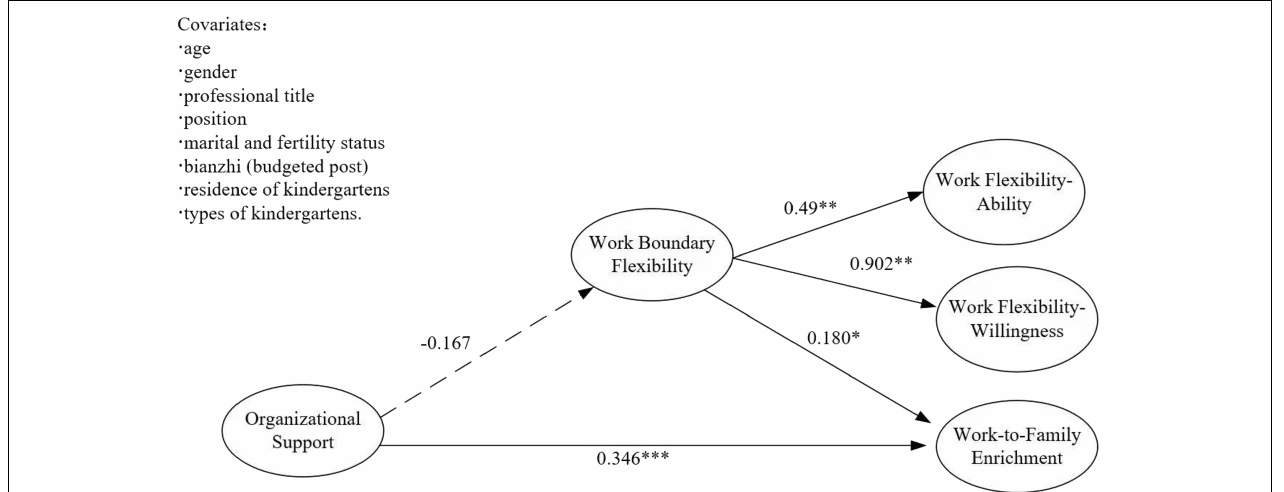
FIGURE 3 | Influence of OS on WFE: work boundary flexibility as the